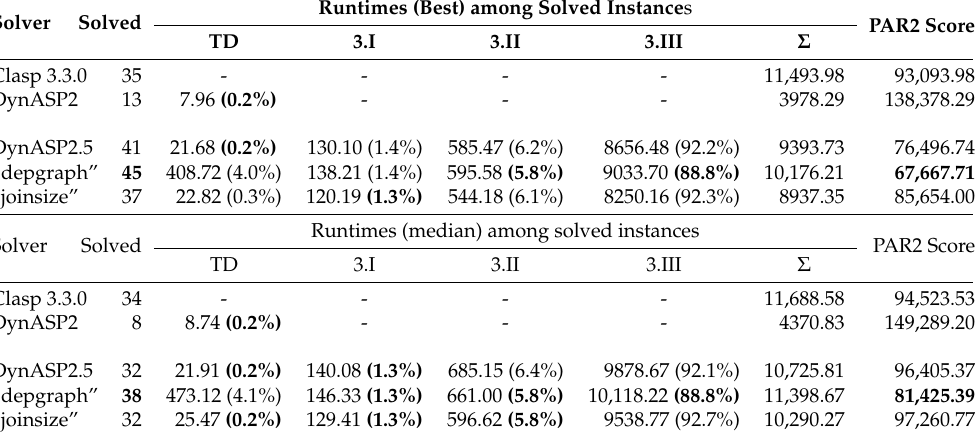
Table 1. The table illustrates detailed benchmark results, where data for the best possible among all five runs is depicted (top) and results for the median run are shown (bottom). All columns illustrate values in seconds, except the first two columns. Column “Solver” indicates a solving system or configuration and “Solved” refers to the number of solved instances. Then, columns “TD”, “3.I”, “3.II”, and “3.III” list the total runtime in seconds over all solved instances for computation involving obtaining TDs, Pass 3.I, Pass 3.II, and Pass 3.III, respectively. Column “ Σ ” refers to the total runtime in seconds over all solved instances. The last column depicts the PAR2 score over all instances, where timeouts are treated as two times the timeout (“PAR2 score”). Bold-face text indicates the best result in the corresponding